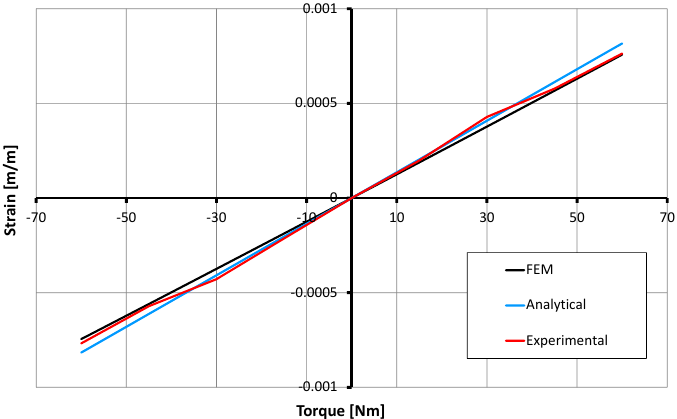
Figure 20. The comparison between finite element method (FEM) simulation, analytical estimation (see Equation (4)) and direct experimental results.